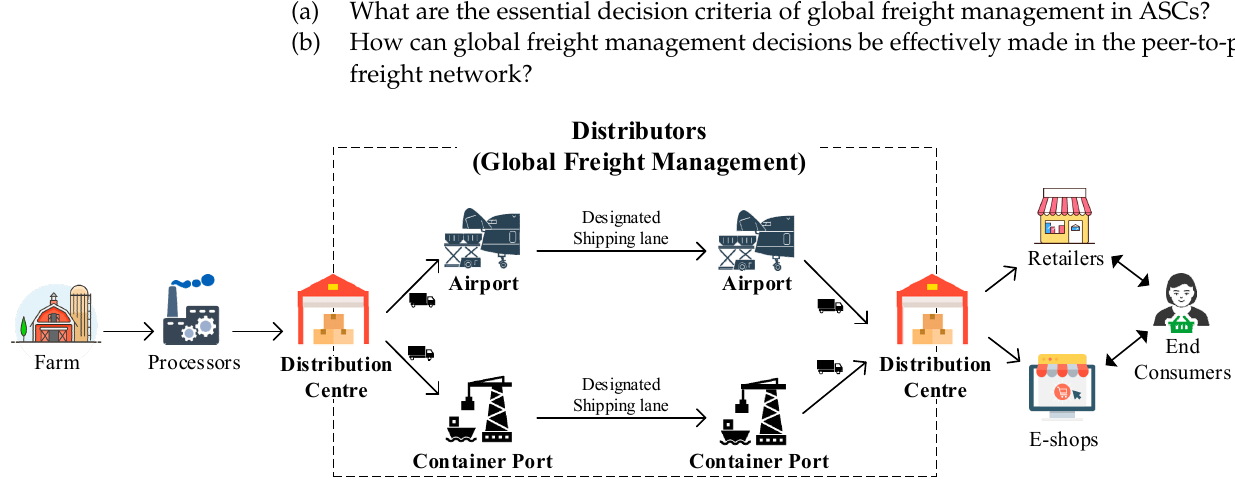
Figure 1. Graphical illustration of the global freight management for agricultural supply chains.